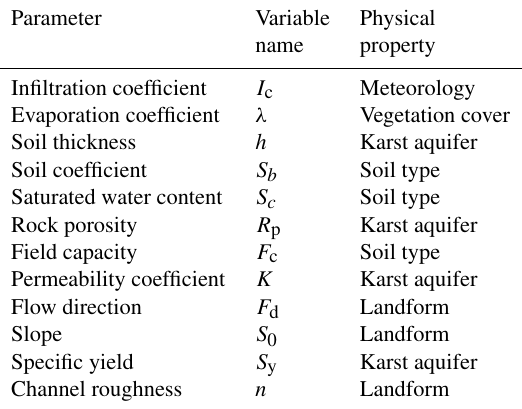
Table 1. Parameters of the QMG